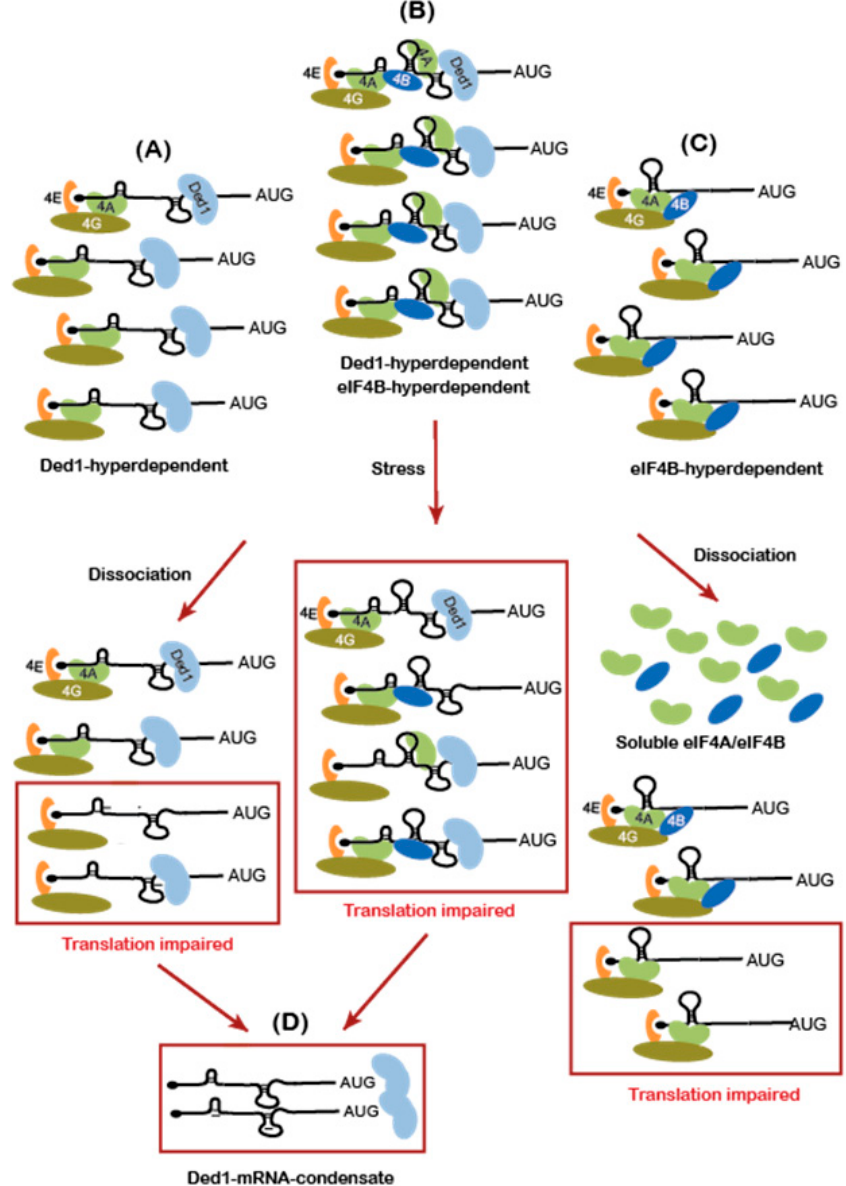
Figure 6. Hypothetical model for compound effects of the Ded1 condensation and dissociation of eIF4B and eIF4A from mRNAs in conferring the reduced translation of a select group of Ded1-hyperdependent mRNAs with a heightened dependence on eIF4B/eIF4A during glucose starvation. Three groups of mRNAs are depicted, two of which are hyperdependent on Ded1 ( A , B ) and two of which are hyperdependent on eIF4B ( B , C ). The Ded1-hyperdependent mRNAs have cap-distal stem-loop structures dependent on Ded1 for unwinding to enable the efficient scanning of the 5 ′ UTR ( A , B ), and the group co-dependent on Ded1 and eIF4B ( B ) additionally requires eIF4B/eIF4A func- tion for this process. The group dependent on eIF4B but not Ded1 ( C ) is pictured with cap-proximal structures that require eIF4A/eIF4B unwinding to facilitate PIC attachment to the mRNA 5 ′ end. It was observed that during glucose starvation, about twice as much of the bound eIF4A and eIF4B dissociated from the mRNA compared to that observed for Ded1 (Bresson et al. 2020). For simplicity, we depict the dissociation of 50% of the bound eIF4A/eIF4B and 25% of the bound Ded1 from all mRNAs bound by these factors, somewhat less than the ~66% and 33% experimentally measured for glucose starvation (Bresson et al. 2020). Owing to the compound effects of the dissociation of eIF4A, eIF4B, and Ded1, group ( B ) showed a greater proportion of mRNAs exhibiting translational reductions (red box), compared to the other two groups that had heightened dependence on only Ded1 ( A ) or eIF4B ( C ). It was also found that a subset of mRNAs that exhibited a loss of Ded1 from 5 ′ UTRs maintained Ded1 bound to the coding sequences following glucose starvation. This subset of translationally inactive Ded1-mRNA complexes could lead to the formation of Ded1-mRNA con- densates that remove a fraction of these mRNAs and a proportion of Ded1 from the cytoplasmic pool ( D ) that might decrease Ded1 function and the translation of Ded1-hyperdependent mRNAs in glucose-starved cells. For simplicity, the Ded1 bound 3 ′ of the AUG start codon (i.e., in coding